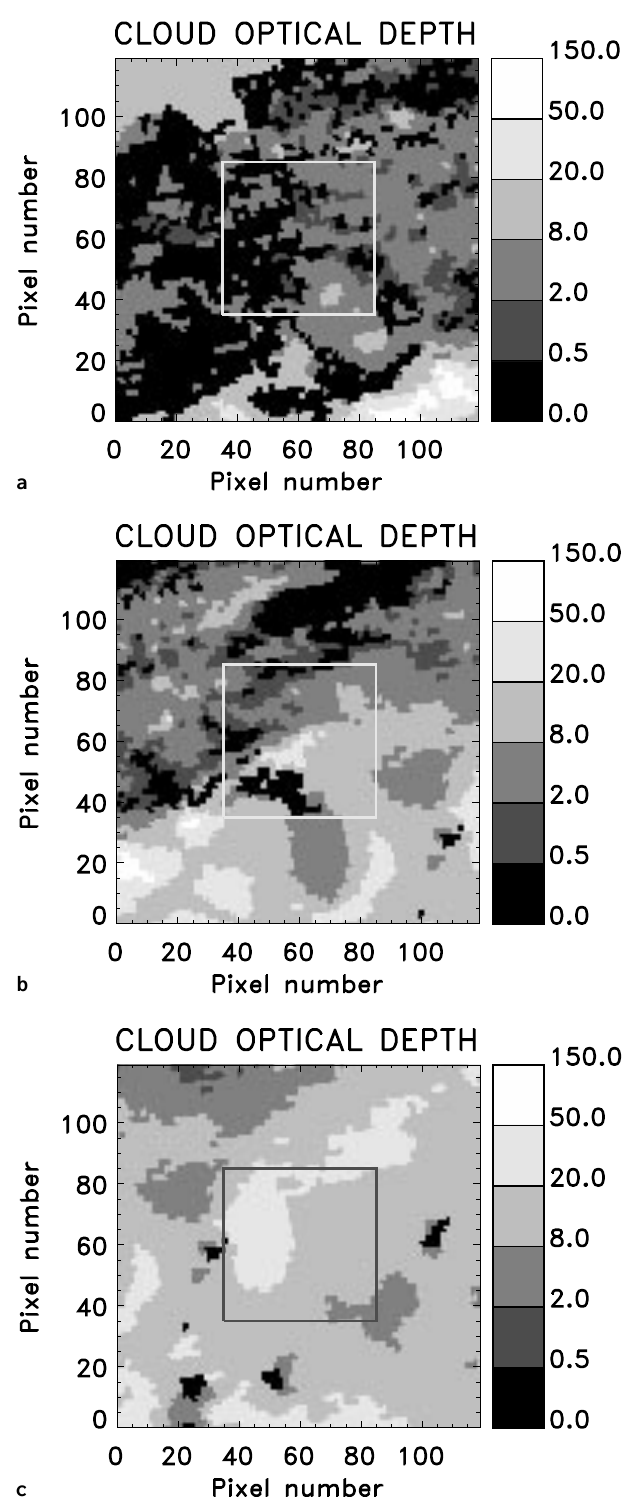
cb Fig. 5a–c. Cloud optical depth distributions obtained from NOAA/ AVHRR data using the APOLLO algorithm (Kriebel et al ., 1989). Due to remapping the pixel size is 500 m (cid:2) 500 m. All three scenes a , b and c are observed on July 01, 1997, over southern Germany at about 13 UTC. The Sun is located in the southwest, i.e., the lower left image corner . The square within each scene marks the atmospheric sector having a horizontal extension of 25 km (cid:2) 25 km, whereas the clouds outside are the remote